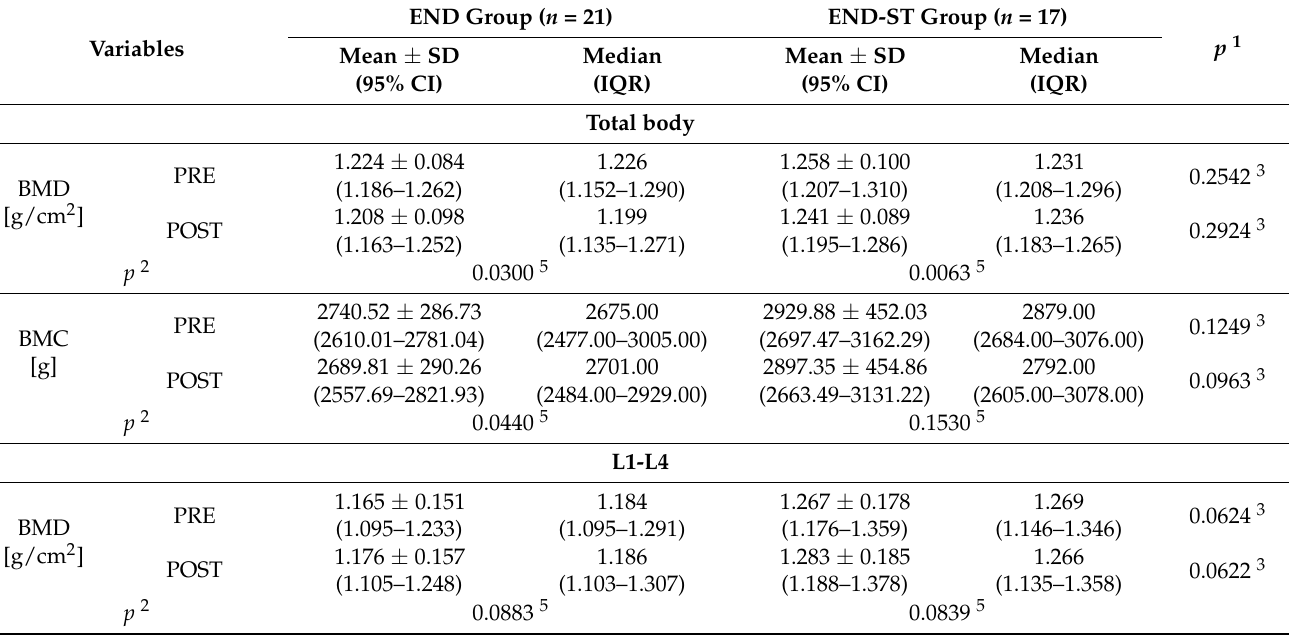
Table 3. The effect of training programmes on bone